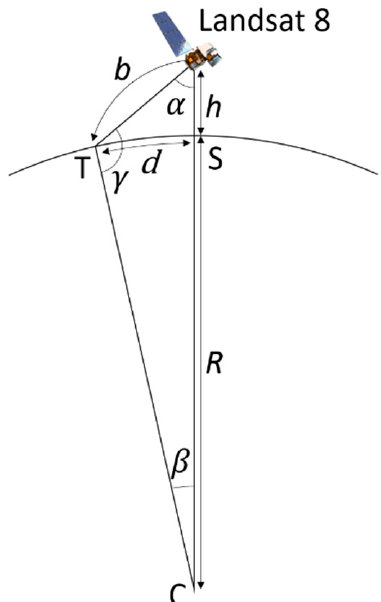
Figure 4. Schematic diagram for geographic definition relating the along-scan distance d to the viewing angle α , where C is the center of the Earth, S is the sub-satellite point, T is the location of target pixel, R is the radius of the Earth, and h is the satellite altitude by following [81].